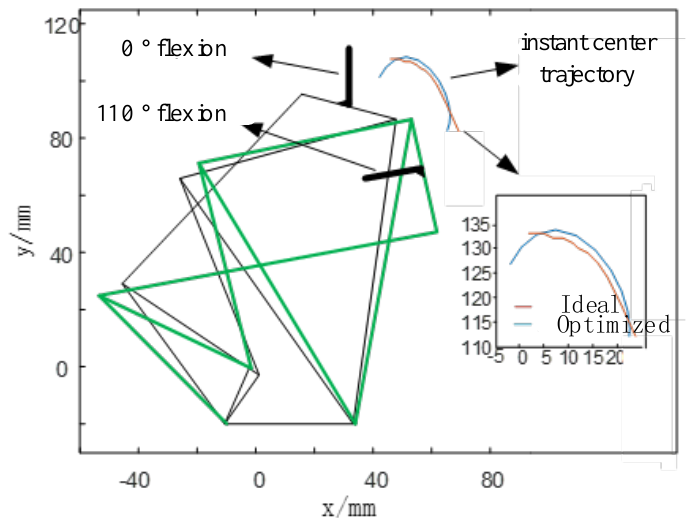
Figure 13. Position of the 6-bar knee prosthesis when it is upright and flexed at 110° .